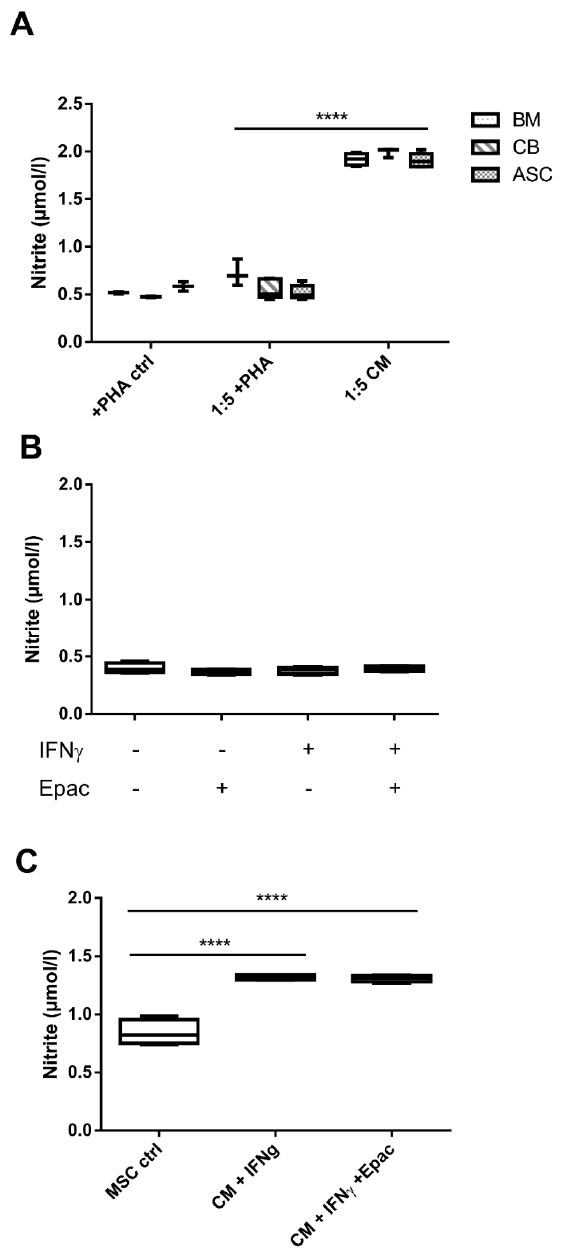
Figure 5. Nitrite concentrations were detectable only in MSC-CM. ( A ) Nitrite concentration levels measured in BM, CB and ASC coculture supernatants. All MSC sources have comparable nitrite production concentration levels, n = 3 to 5. ( B ) Nitrite concentration in coculture supernatants with IFN γ and Epacadostat addition, n = 4. ( C ) Nitrite levels measured in CM + IFN γ after addition of IDO inhibitor Epacadostat, n = 4. Box: interquartile range; whiskers: minimum to maximum; line: median. Lines with asterisks depict the significance between two conditions (**** p < 0.0001 ) .